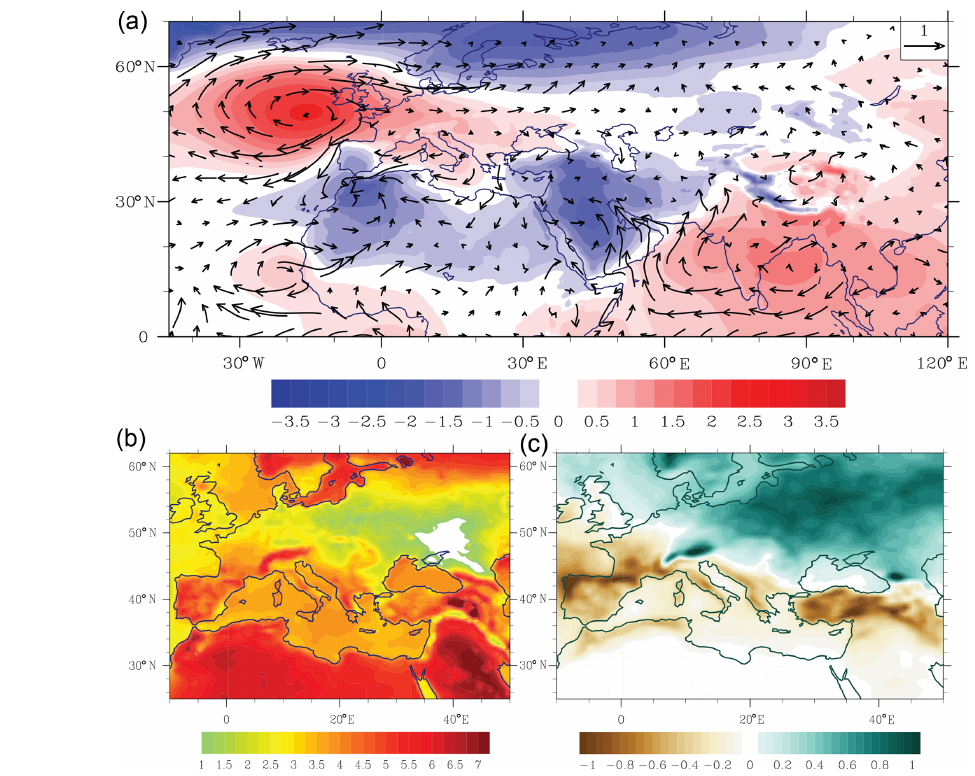
Figure 7. Projected future changes for the summer (JJA) (a) sea level pressure (hPa, shaded) as well as the u and v wind components at 850hPa (ms − 1 ; vectors), (b) surface temperature ( ◦ C), and (c) total precipitation rate (mmd − 1 ) over the period 2061–2099 compared with the baseline period 1961–1999. Changes are derived at the original horizontal